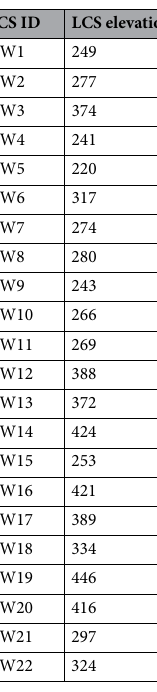
Table 2. Sensor location and elevation in the north-west section (outside the urban areas of Krakow).